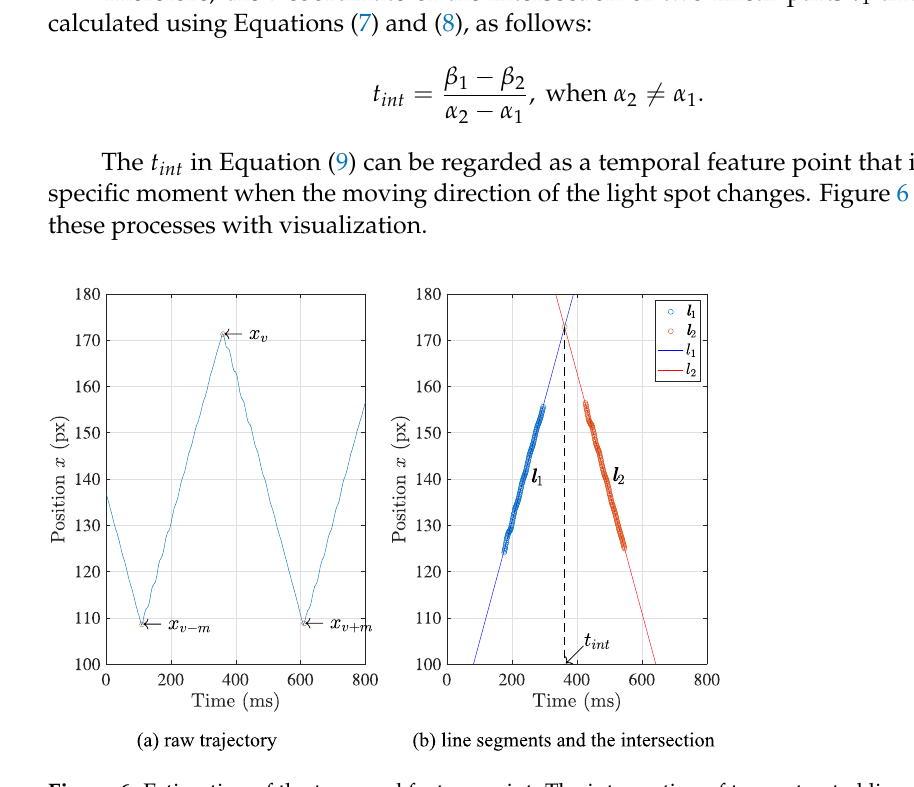
Figure 6. Estimation of the temporal feature point. The intersection of two extracted linear sections is regarded as the temporal feature point to represent the frame